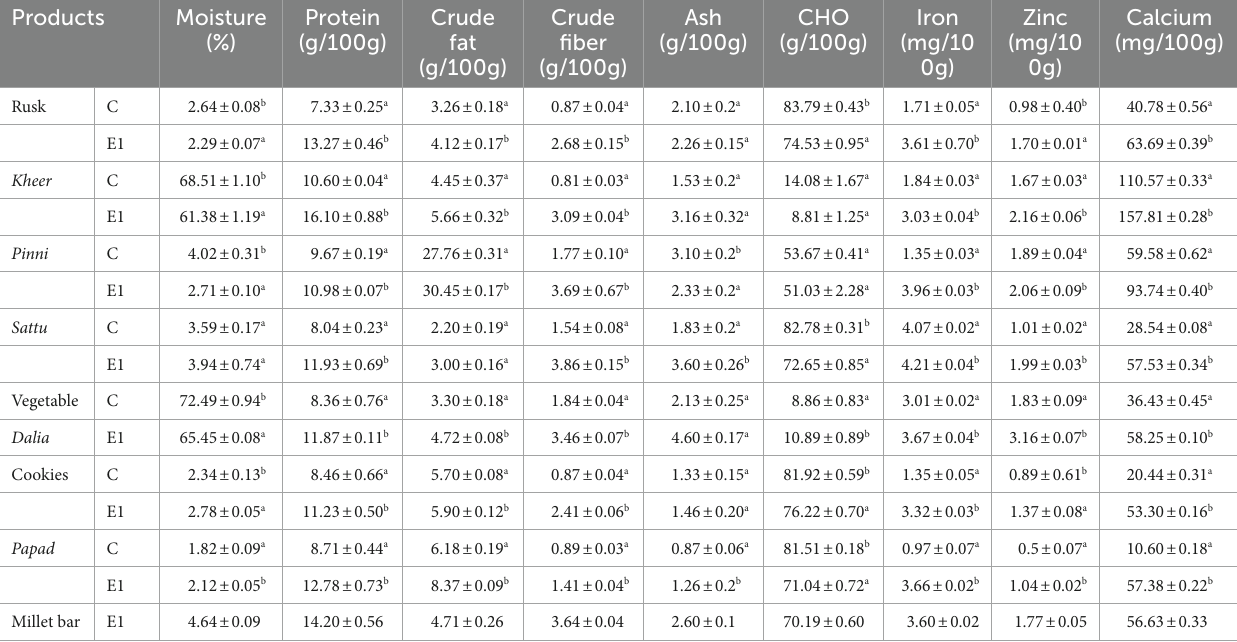
TABLE 4A Nutritional composition of the value added